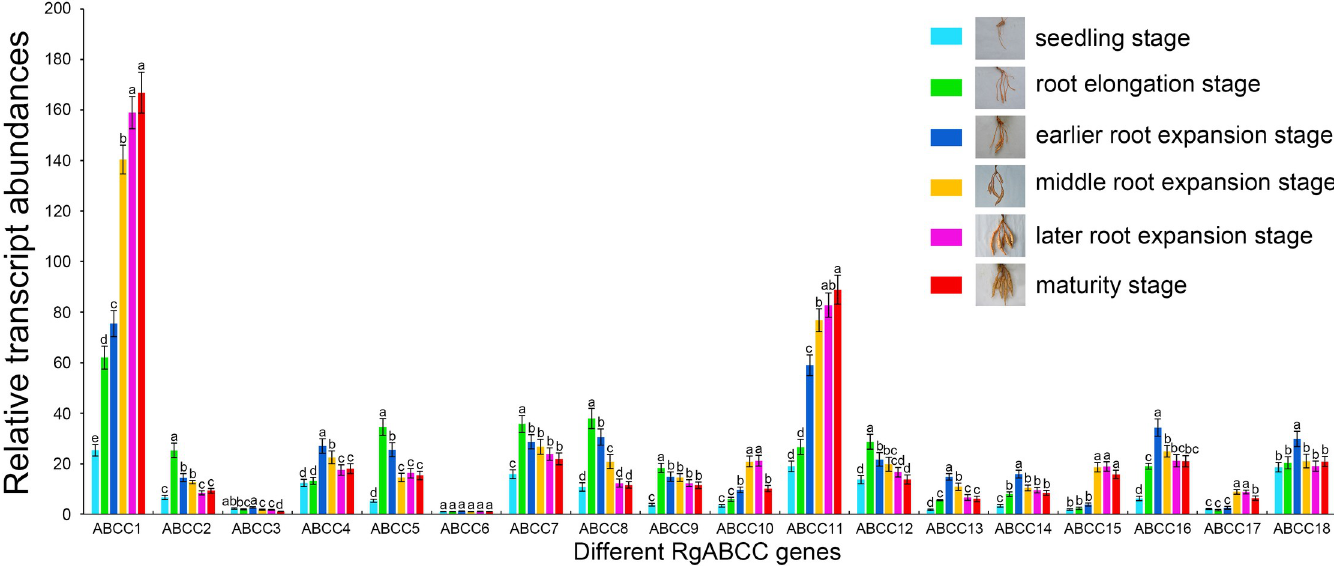
Fig 5. Transcript profiles of the RgABCCs at various root development stages.